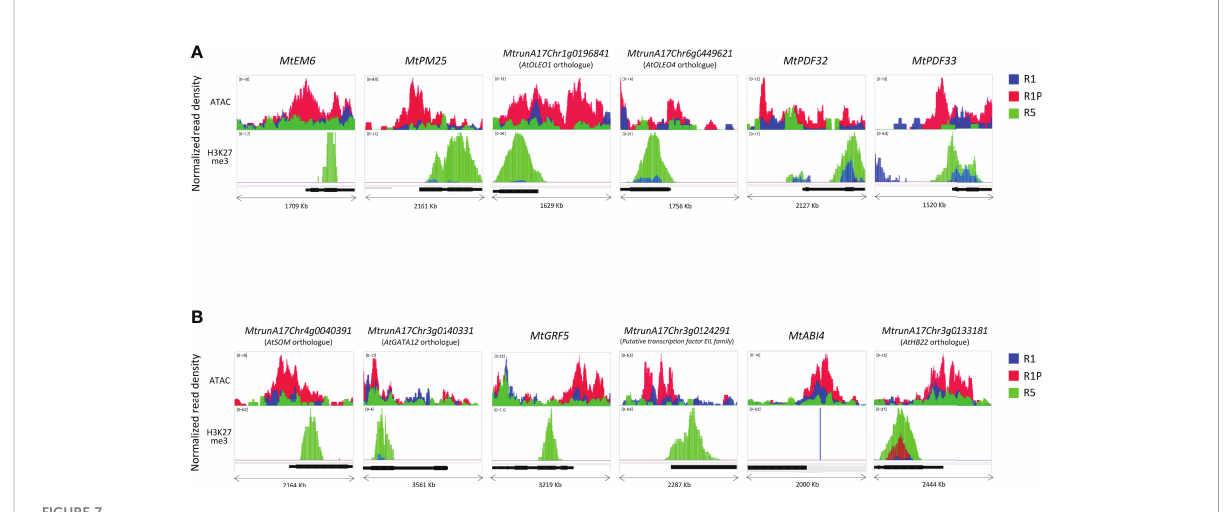
FIGURE 7 Differences in chromatin accessibility and H3K27me3 marks of DT-DAR-genes among R1, R1P and R5. Normalized read density of representative genes (1 Kb promoter + mRNA) was visualized using the Integrated Genome Viewer (IGV) for LEA s, OLEO s and PDF s (A) and transcriptional factors (B) . The black bar below each panel indicates the position of the respective mRNA sequence. The range in square brackets indicates the range of normalized read